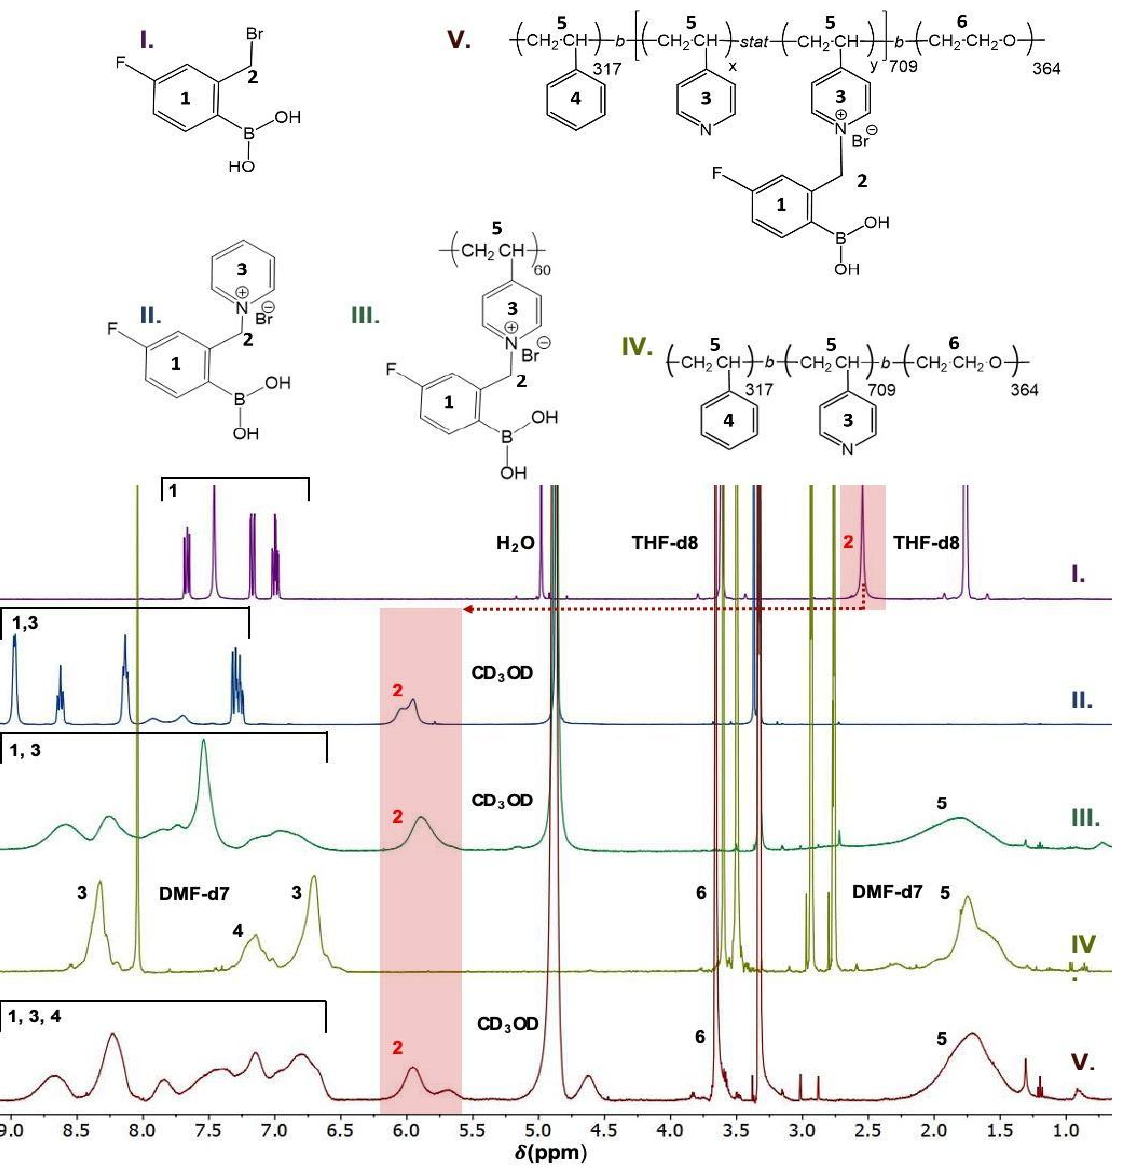
Figure 1. 1 H NMR spectra of (I) FPBA, (II) Pyr-FPBA, (III) P4VP-FPBA, (IV) SVE and (V) SVE-FPBA. The shift of the methylene linker after quaternization is highlighted in red.